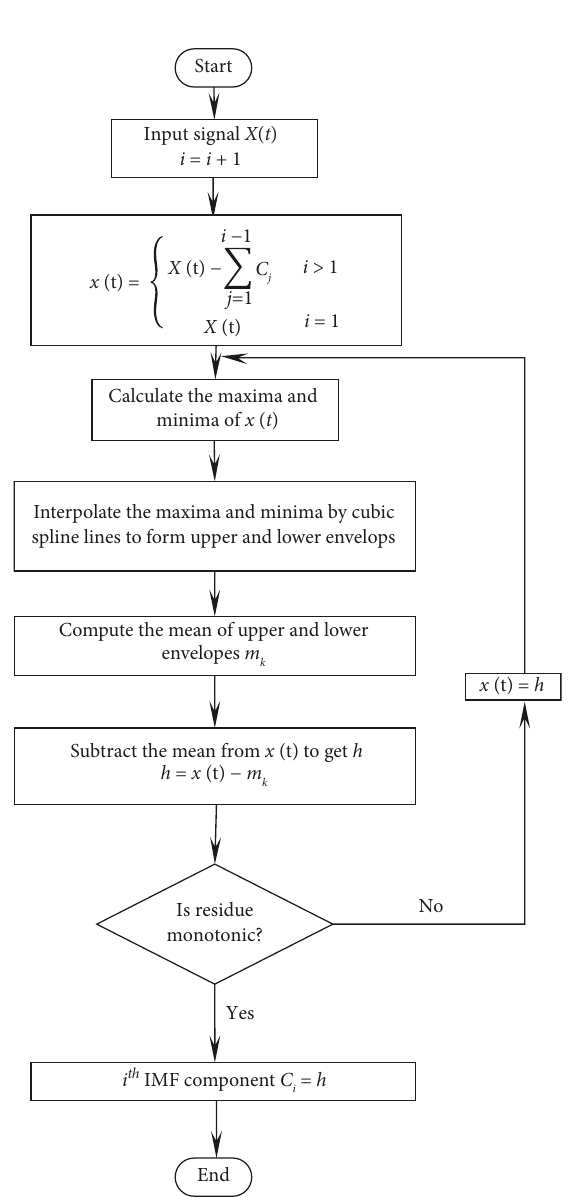
Figure 1: Sifting flow chart of i th IMF component.